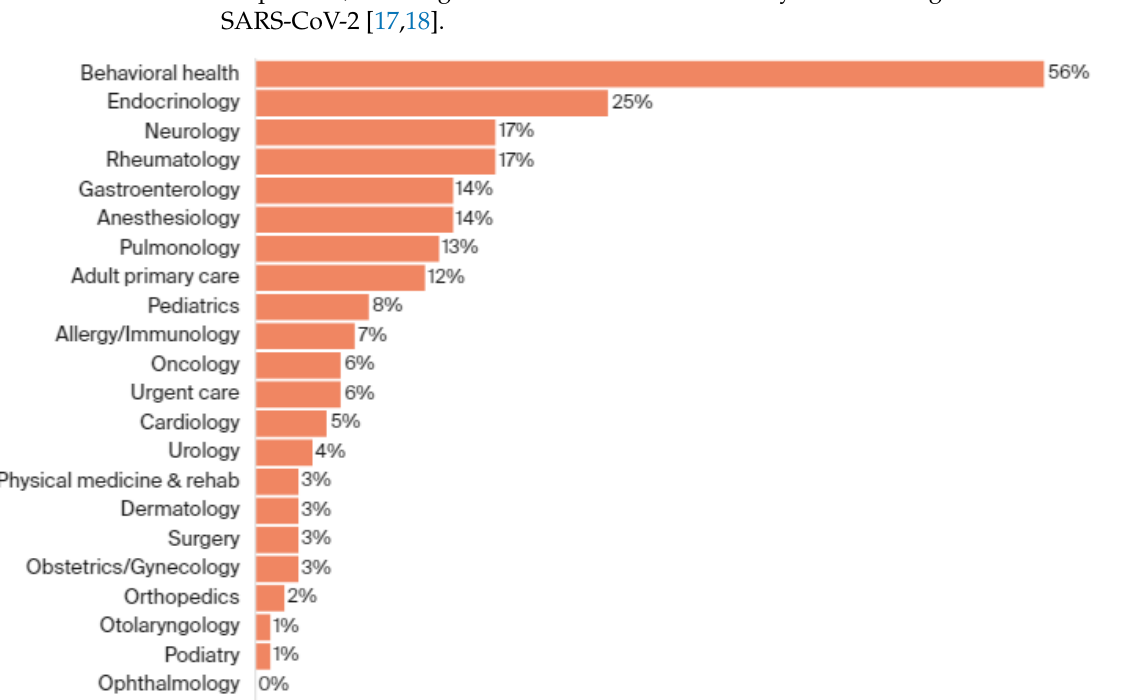
Figure 2. Telemedicine visits as a percentage of baseline. Data presented are expressed as a percentage. The number of telemedicine visits over the final three nonholiday weeks of 2020 is the numerator, while the number of visits in the baseline week 1–7 March multiplied by three is the denominator. Telemedicine includes both telephone and video visits. Shortened weeks or holidays were not included. (Reproduced with permission from Commonwealth Fund [11].)